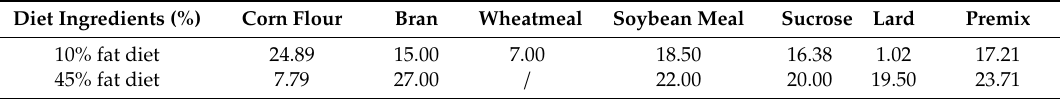
Table 1. Diet formula of mice in this study.